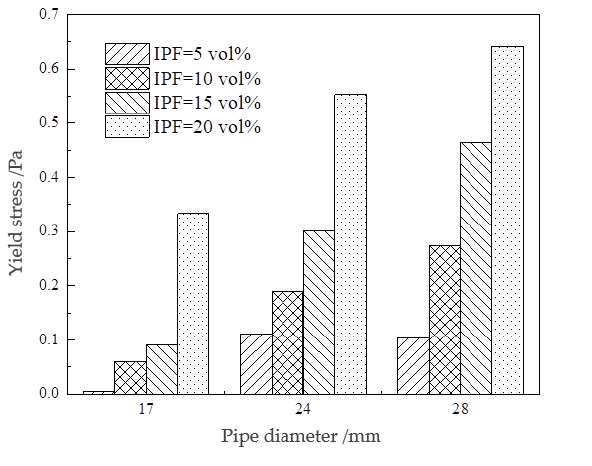
and ( b ) the relationship between yield stress and particle size.